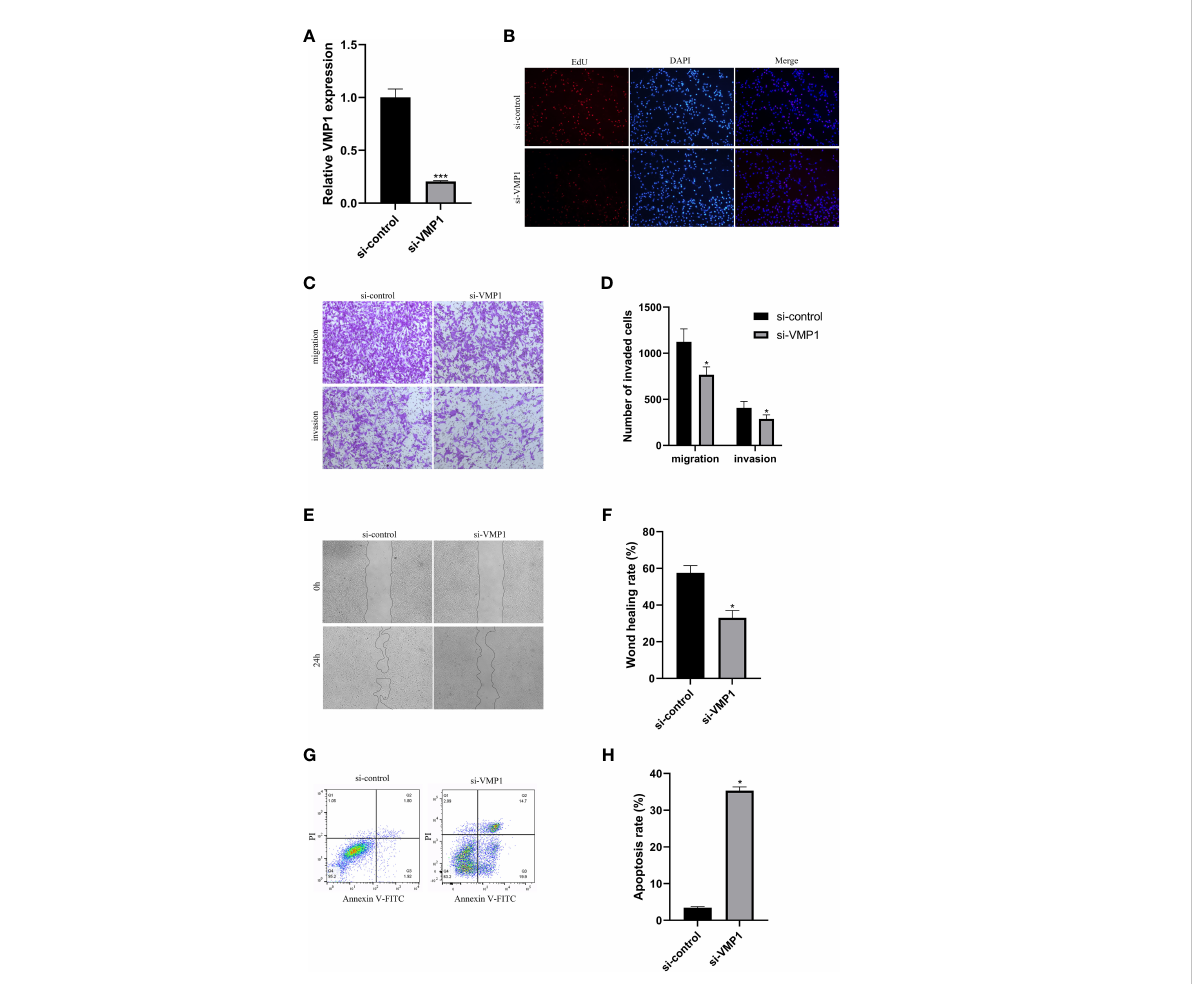
FIGURE 10 Cell experiments. (A) qRT-PCR analysis was performed to con fi rm the knockdown of gene VMP1. (B) EdU assay suggested that the proliferation ability of 786-O cells was reduced with VMP1 knockdown. (C, D) Transwell assay showed that the migration and invasion of 786-O cells were reduced with VMP1 knockdown. (E, F) Scratch assay showed that the migration of 786-O cells was reduced with VMP1 knockdown. (G, H) Cell apoptosis assay showed that the apoptosis rate of 786-O cells was Increased with VMP1 knockdown. *p<0.05,